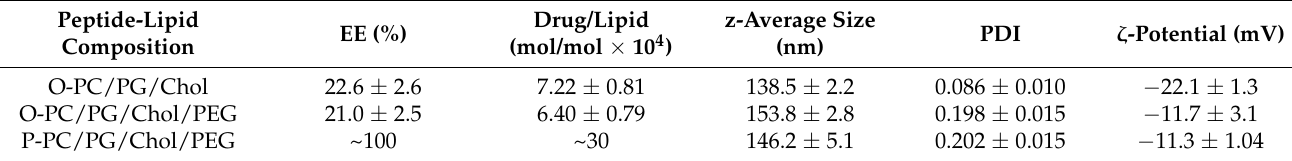
Table 2. Physicochemical properties of O-RLX2 (O) loaded and P-RLX2 (P) incorporating liposomes (PC/PG/Chol (8:2:5) or PC/PG/Chol/PEG (8:2:5:1.3)). Each value reported is the mean of at least three different samples; corresponding SD values are